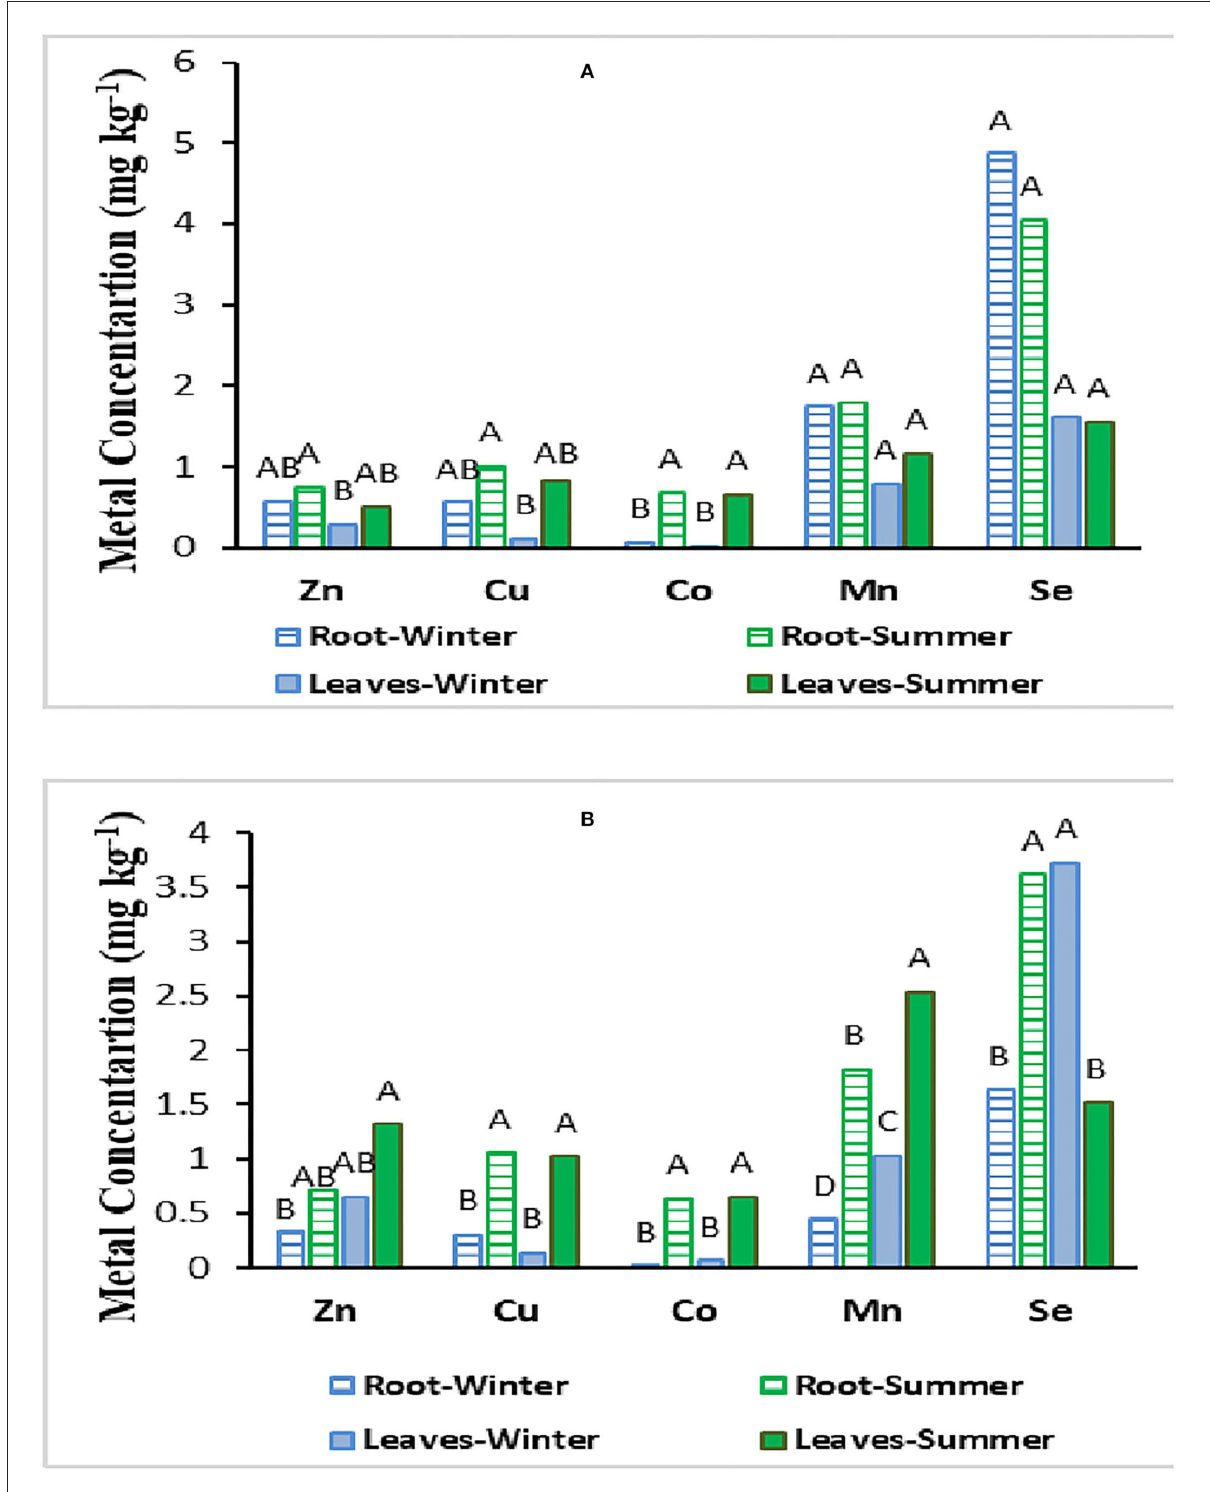
FIGURE3 Metal concentrations in above- and below-ground biomass of Juncus acutus (A) and Hammada salicornica (B) plant species collected in winter and summer of